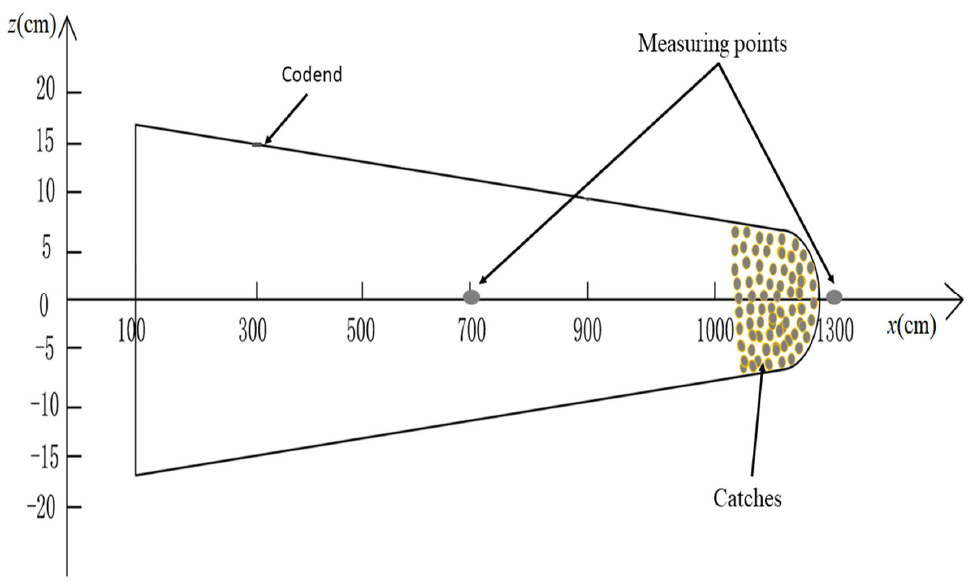
Figure 4. Schematic of the experimental setup of flow velocity measurement inside and behind codend: The two grey solid dot indicates the measurement points.